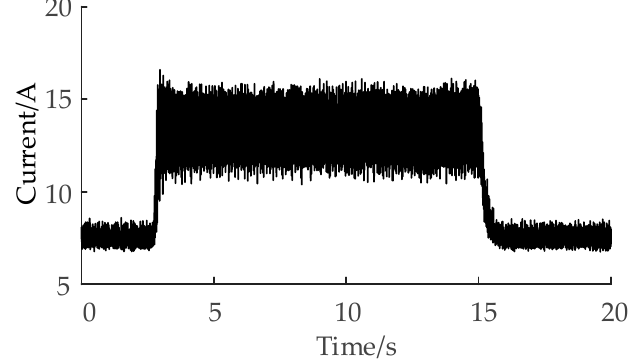
Figure 1. Collected current signal based on the Fanuc Servo Guide software.